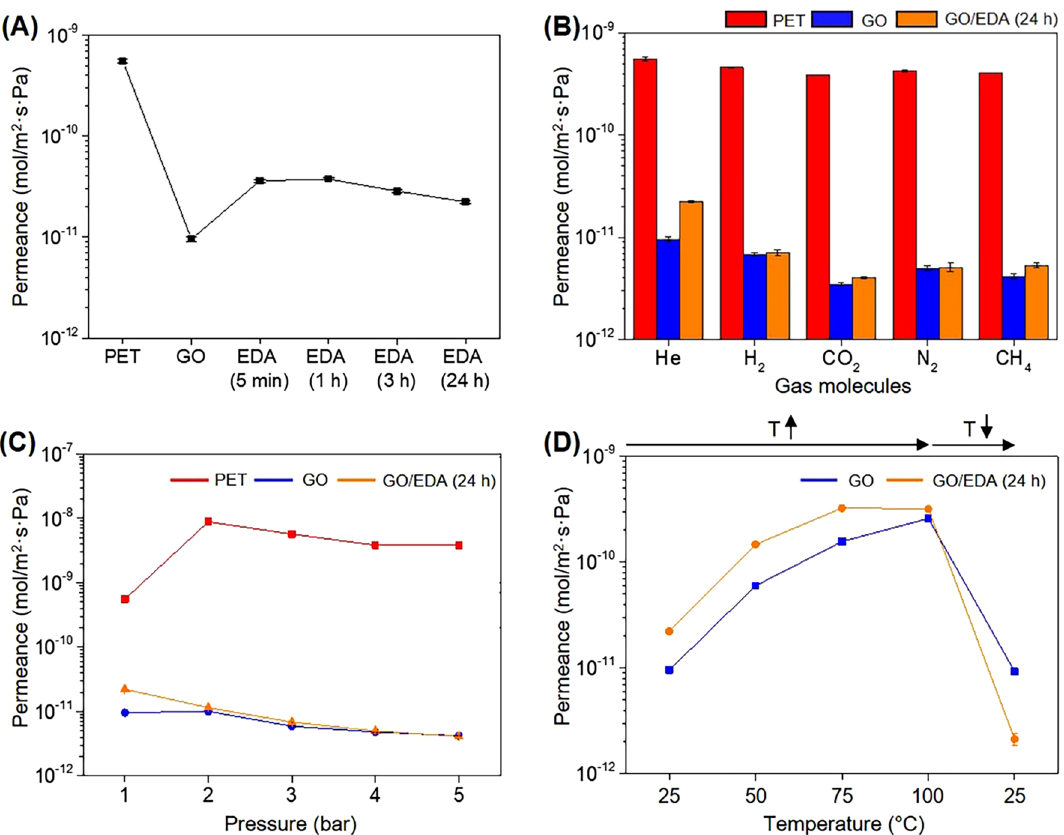
Figure 7. ( A ) He gas permeance of PET and GO/EDA depending on EDA exposure time. The thickness of GO was approximately 1 μm. ( B ) Gas permeances of neat PET, GO coated PET, and GO/EDA (24 h) coated PET. ( C ) He gas permeance of PET, GO coated PET, and GO/EDA (24 h) coated PET as a function of pressure. ( D ) He gas permeance of GO and GO/EDA (24 h) coated PET as a function of temperature. Each point represents the average of a minimum of three